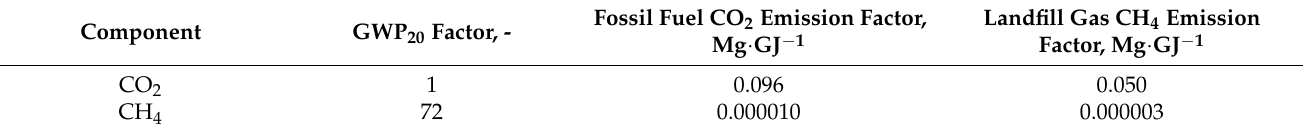
Table 6. Greenhouse gases from fuel combustion, their GWP, and emission factors